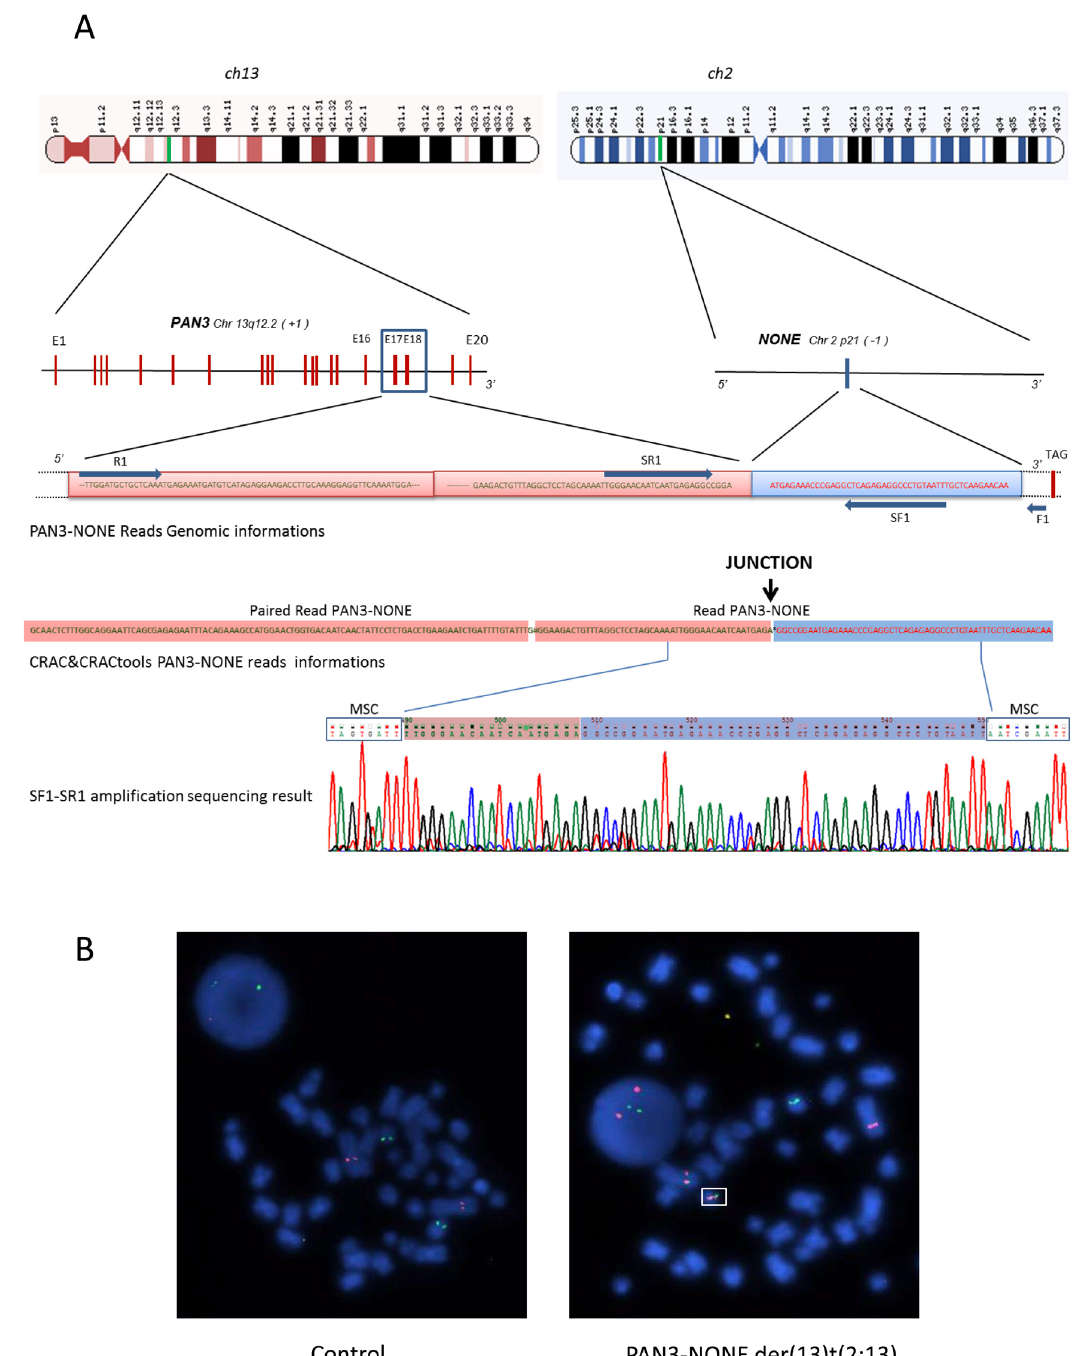
Figure 1. A new specific Class 1 PAN3-NONE chimera. A ) Fusion junction description and primer design. The sequences of spanning junctions and paired reads supporting the chRNA and the corresponding designed primers are indicated. The orange and blue squares represent respectively the E17 and E18 of PAN3 gene (E16 of ENST00000399613.1 transcript), and the NONE part of the fusion transcript. The sequencing result of the PAN3-NONE SF1-SR1 PCR product is indicated. The symbol (#) denotes the part of the read which was not sequenced, (*) denotes the junction, and MCS indicates the multiple cloning sites used to clone the PCR product. ( B ) Translocation checking by FISH. The left panel (Control) represents normal blood cells and the right panel represents cells from patient OS110089. The presence of the NONE sequence on chr2 is denoted by the red signal and the presence of the PAN3 sequence on chr13 mentioned by the green signal. The right panel presents the NONE-PAN3 fusion at the chromosomal level (white